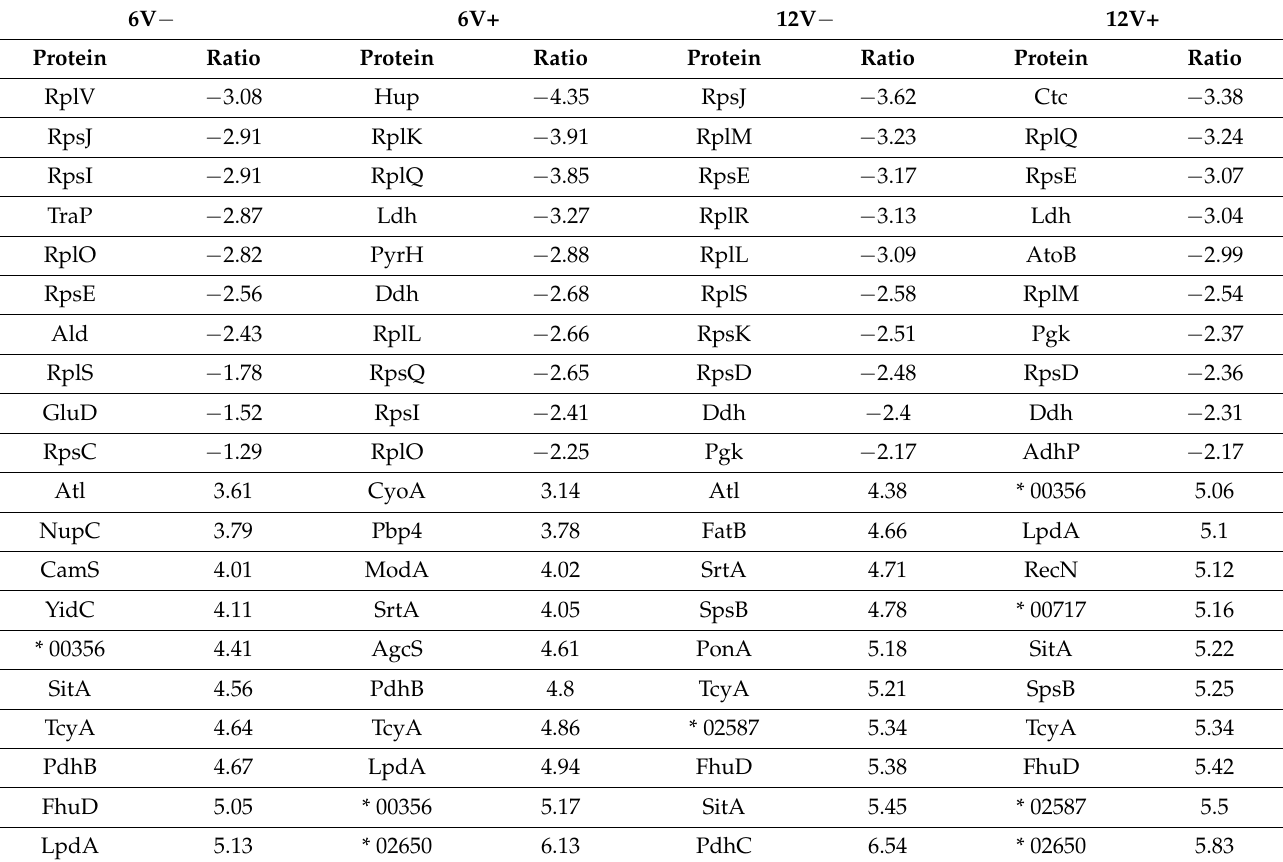
Table 1. The top ten most abundant and less abundant proteins in EVs compared to WC in all conditions that were tested. Ratios correspond to the relative abundance of proteins (log2FC) between EVs and WC (EV/WC) conditions at 6 h without vancomycin (6V − ), 6 h with vancomycin (6V+), 12 h without vancomycin (12V − ), and 12 h with vancomycin (12V+). 6V+ 12V −